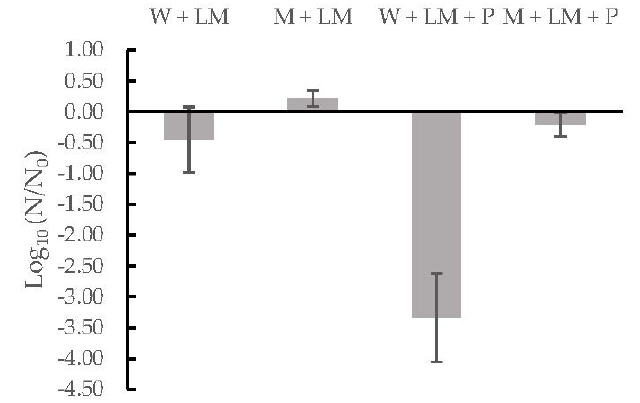
Figure 2. Inactivation level of ingredients’ different combinations: peptone water (W), milk (M), inoculated Listeria monocytogenes (LM), and pomace (P).